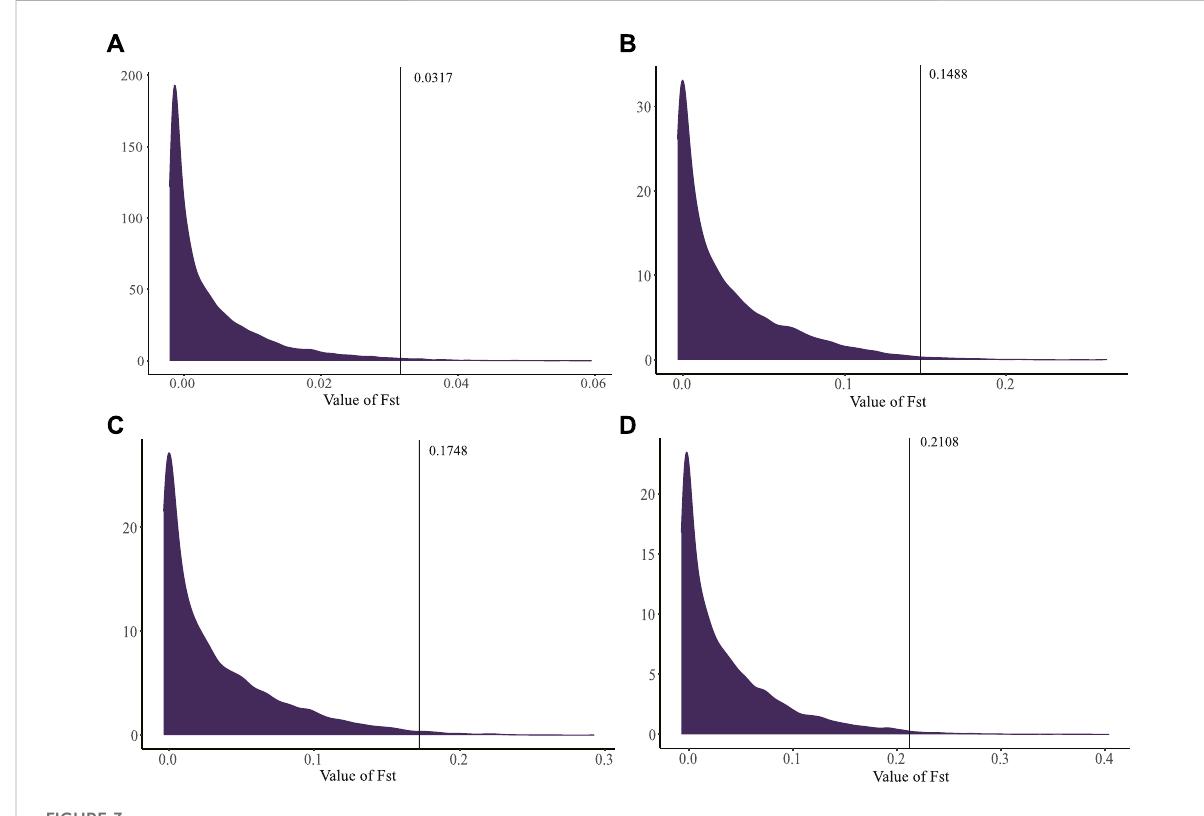
FIGURE 3 Distribution of Fst density on chromosome. (A) Analysisbetween 114and 115 days. (B) Analysis between 114 and 116 days. (C) Analysis between 114and117 days. (D) Analysisbetween114and118 days.Theblacklinesindicated320SNPsinthetop1%(FST > 0.0317,0.1489,0.1748and0.2108for 114 and 115/116/117/118 days,